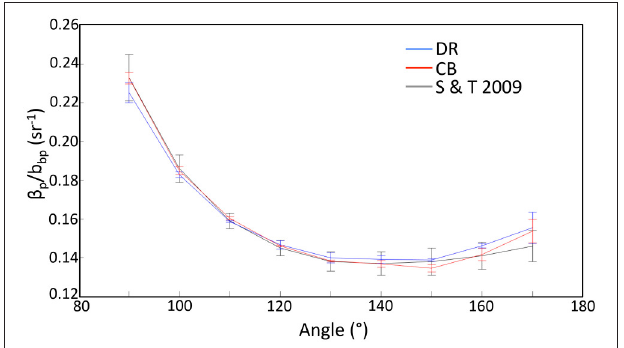
FIGURE 9 | VSF functions from different regions.